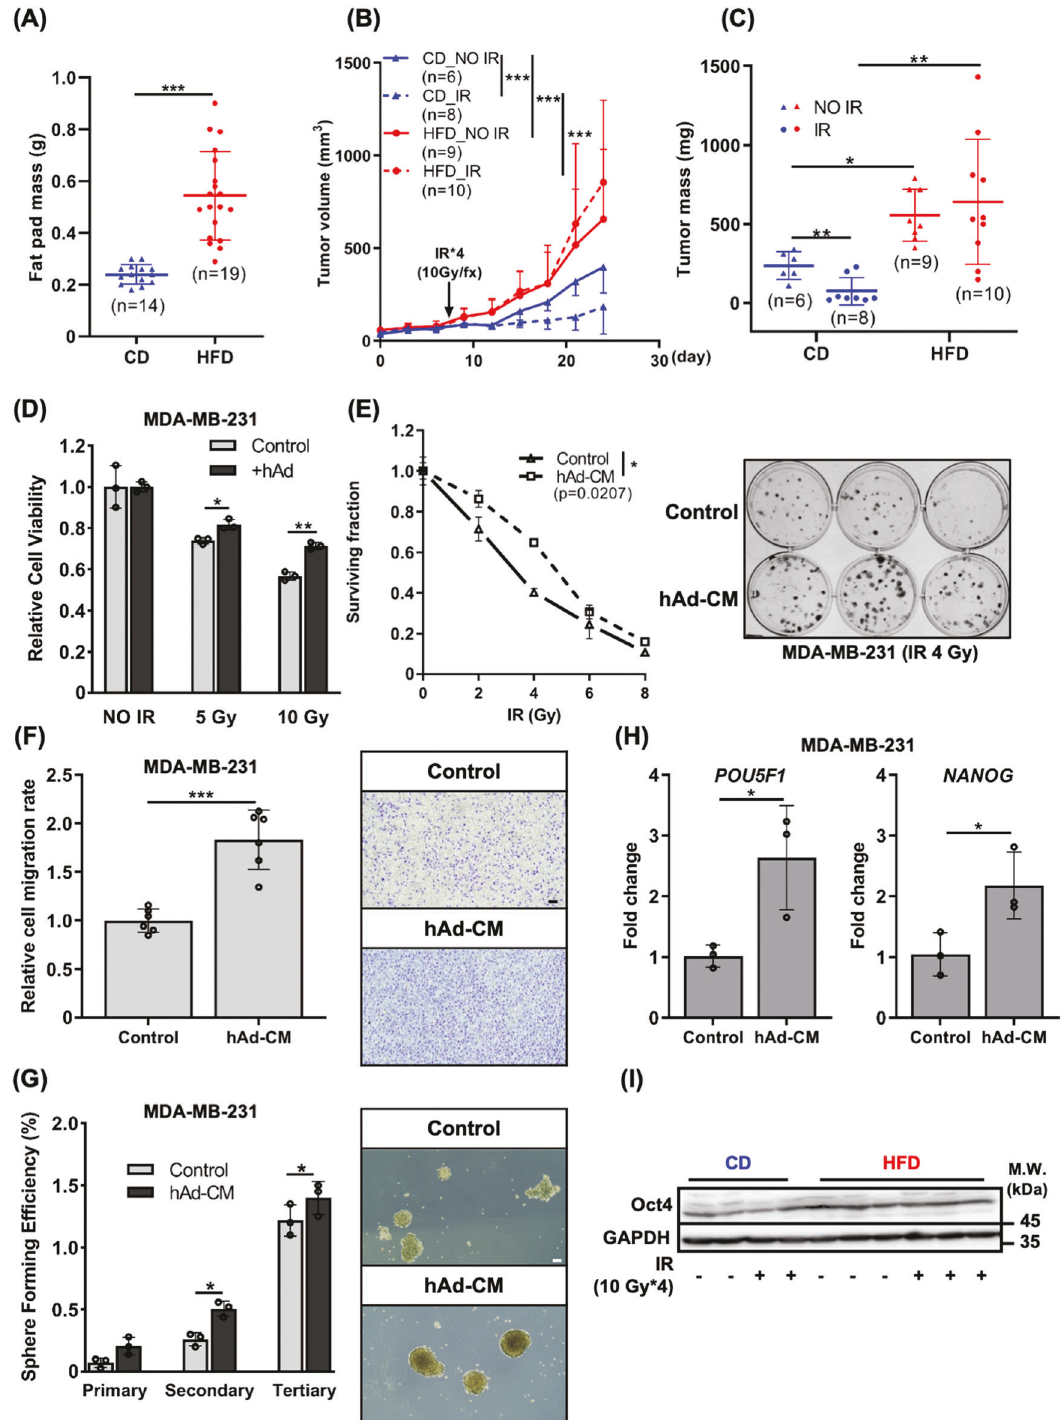
Fig. 1 Obesity-mimicking conditions elicited radioresistance and aggressive phenotypes in TNBC. A Weight of iWAT excised from the mice fed with CD or HFD. B , C Tumor volume was measured every 3 days post-tumor implantation and mass was assessed after euthanasia. D Cell viability of MDA-MB-231 cells co-cultured with hAd for 3 days followed by IR was assessed by ACP assay. E Clonogenicity of MDA-MB-231 cells cultured with control medium or hAd-CM followed by IR. Representative image of colony formation after 4 Gy exposure was shown on the right panel. The migration and stemness capacity of MDA-MB-231 cells pre-treated with control medium or hAd-CM for 3 days were determined by transwell migration assay ( F ) and tumorsphere formation assay ( G ). Representative images were shown on the right panel. Scale bar: 100 μ m. H mRNA expression of pluripotent genes, NANOG and POU5F1 , were detected by qPCR. I Western blotting of Oct4 expression in tumors collected from the mice fed with CD or HFD.